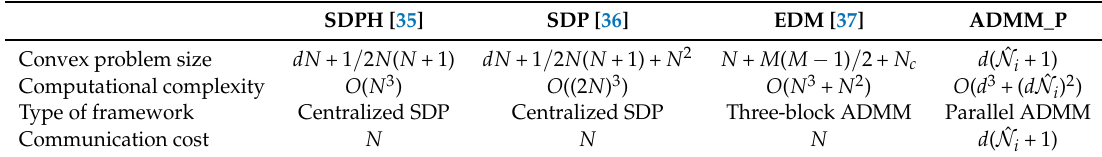
Table 1. Complexity comparison of available